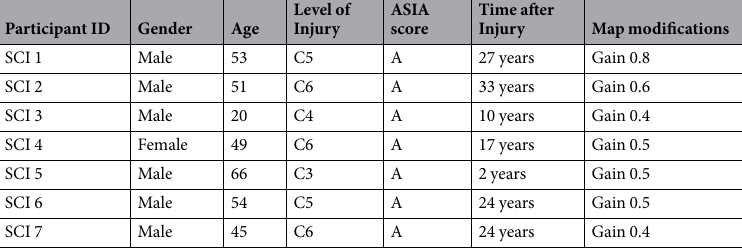
Table 1. Participants ’ demographic and modifications